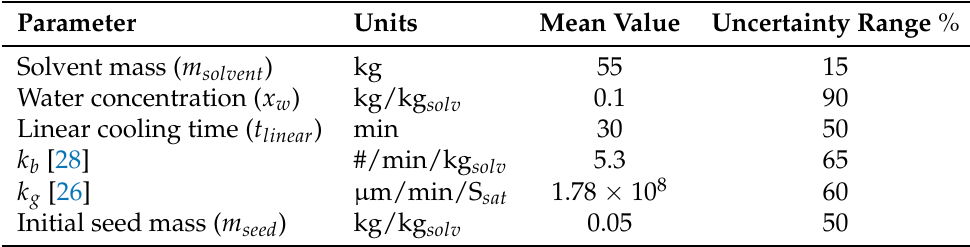
Table 1. Disturbances applied in the control applications and their uncertainty